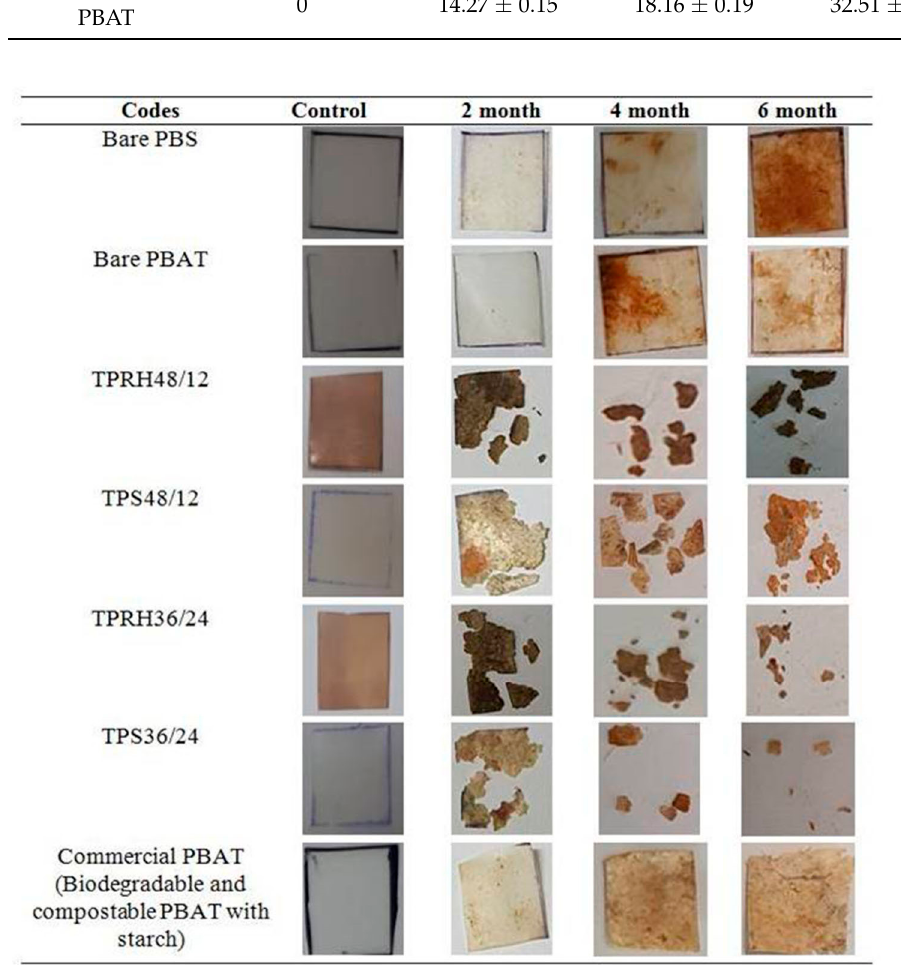
Figure 8. Macroscopic appearance of biodegradation in the soil at different burying times.